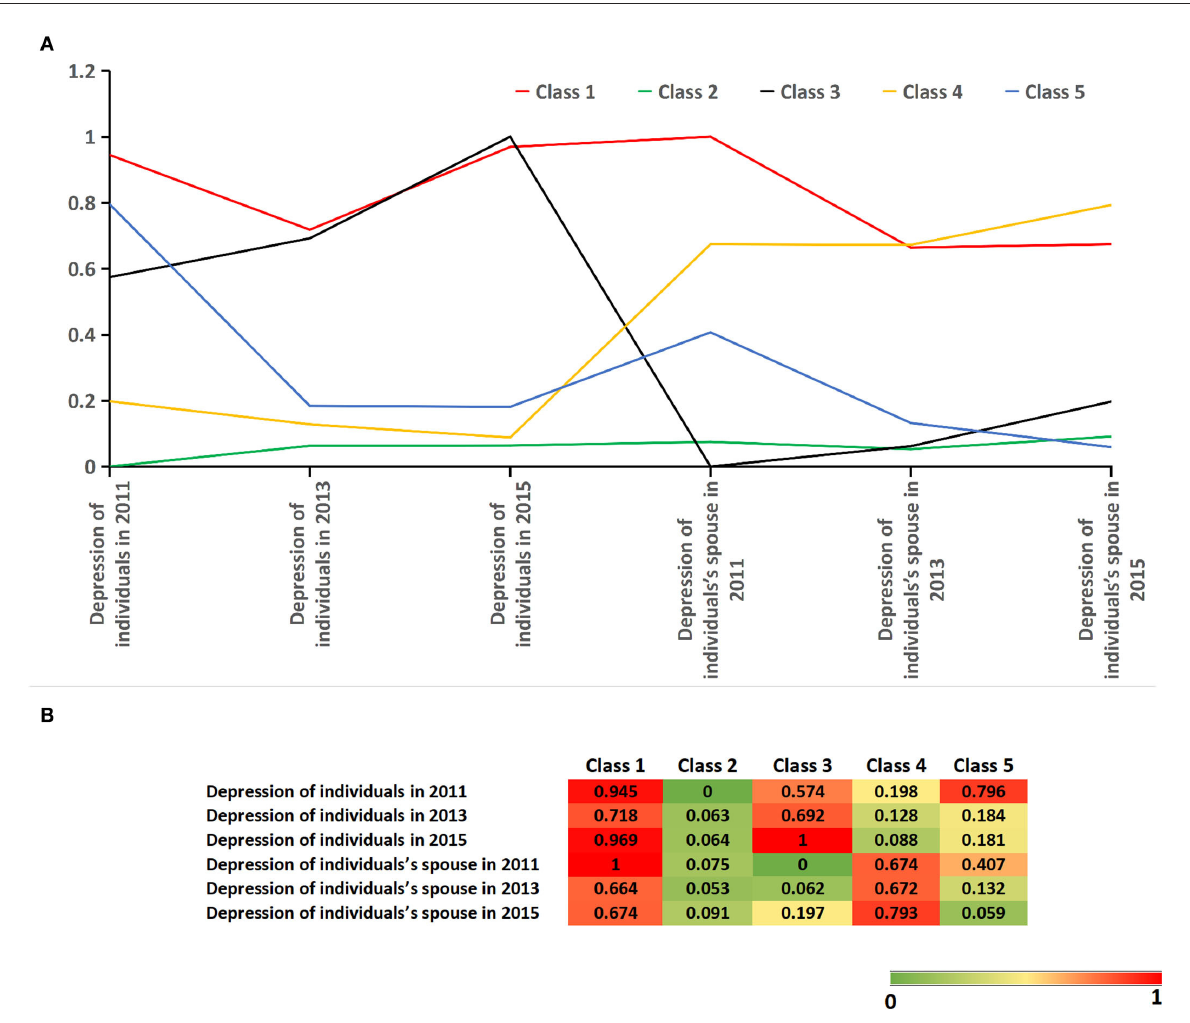
FIGURE2 (A) Latent class analysis (LCA) of depression trajectories in individuals and their spouses. Class 1: a persistently high risk of depression in individuals and their spouses (reference; n = 34 [4.3%]); class 2: a persistently low risk of depression in individuals and their spouses ( n = 526 [67.1%]); class 3: a high risk of depression in individuals and a low risk of depression in individuals’ spouses ( n = 46 [5.9%]); class 4: a low risk of depression in individuals and a high risk of depression in individuals’ spouses ( n = 116 [14.8%]; and class 5: the decreased risk of depression in individuals and their spouses ( n = 62 [7.9%]. (B) Probability of each indicator variable in five depression